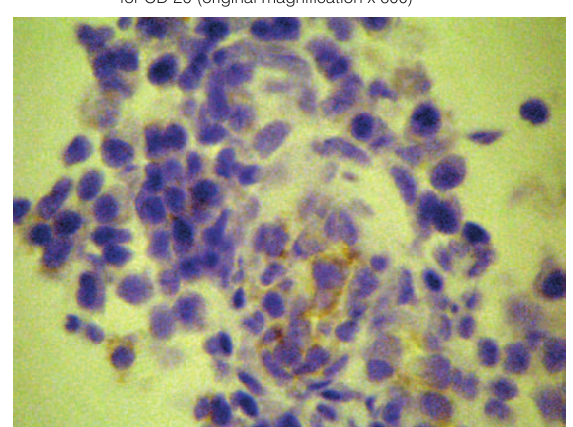
Figure 3. Intravascular large B-cell lymphoma - immunostaining for CD 20 (original magnifi cation x